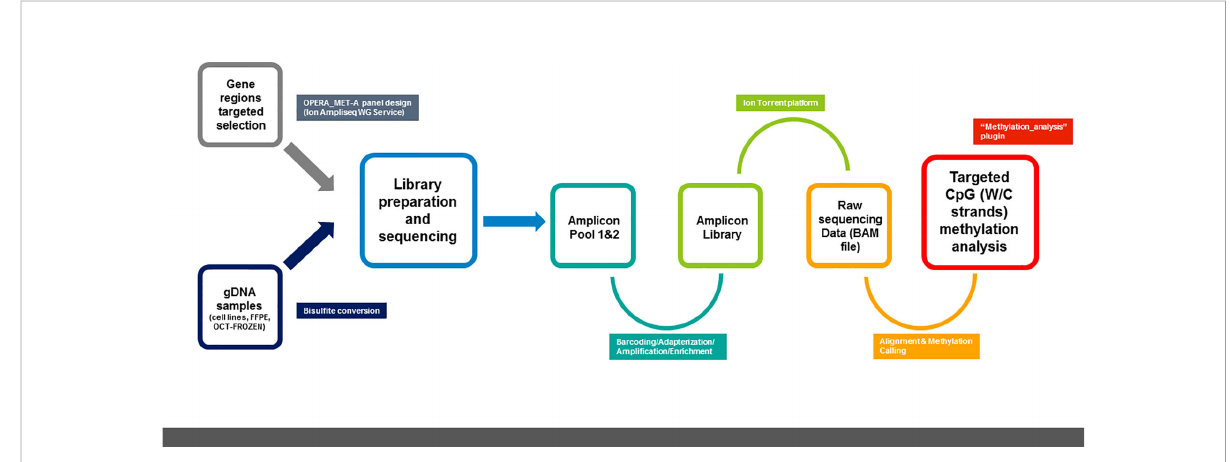
FIGURE 5 Schematic representation of methylation NGS analysis work fl ow using OPERA_MET-A